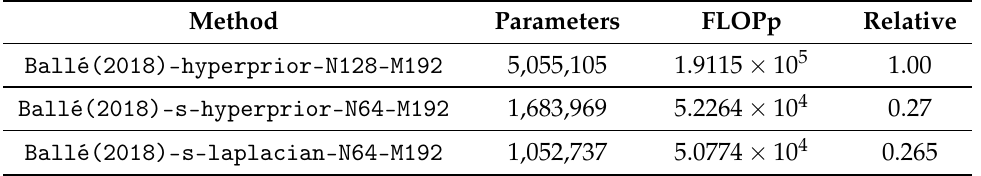
Table 2. Comparative complexity of the global architectures-Case of target rates up to 2